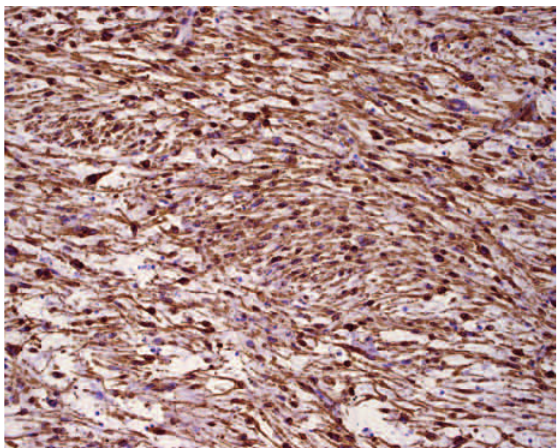
Figure 6. Tumor cells with positive immunohistochemistry staining for SMA (zoom x